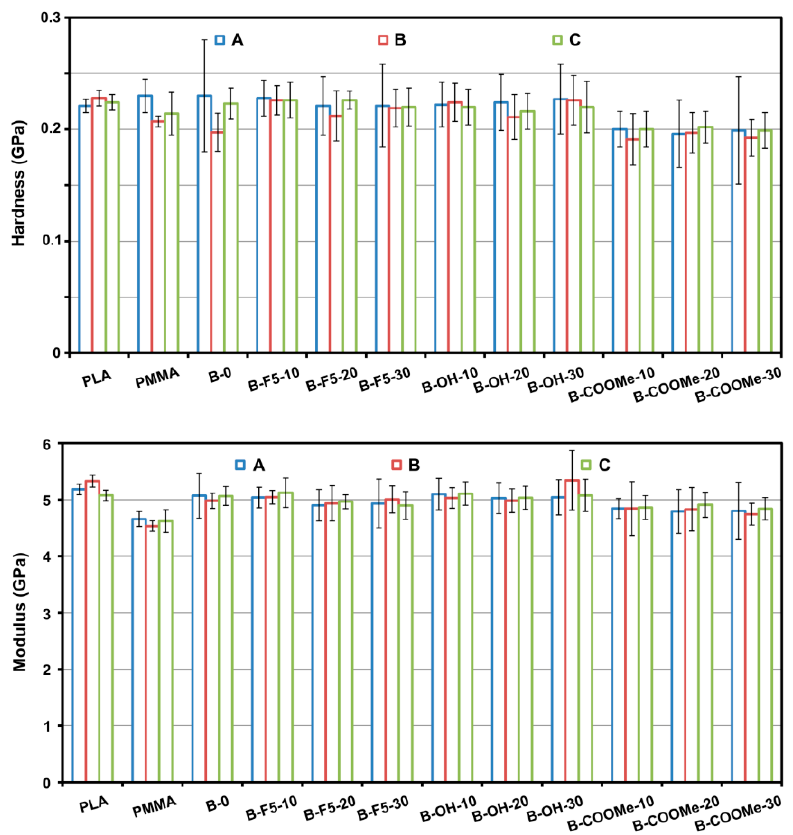
Figure 10. Average mechanical properties (hardness H and elastic modulus E ) in the studied samples (A: along the surface B: cross-section at the edge; C: cross-section, middle area).